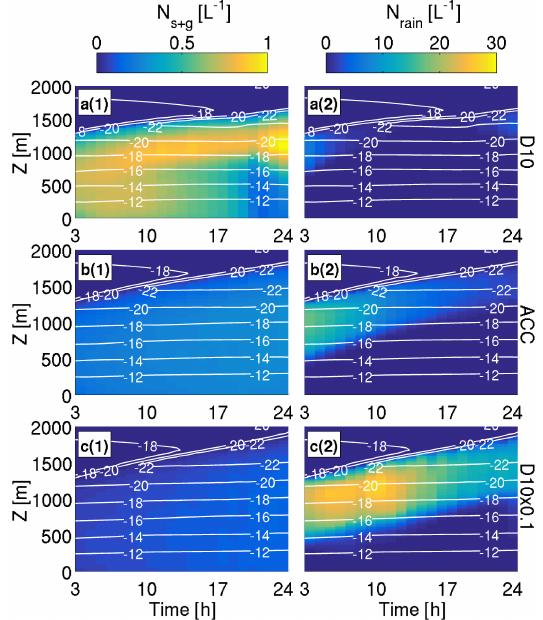
Figure 12. Summed snow and graupel number concentrations ( N s + g , a1–c1 ) and rain number concentration ( N rain , a2–c2 ) us- ing (a) D10 , (b) ACC, and (c) D10 × 0.1 during case 3. Run length 24h. Temperature ( ◦ C) contours are overlaid in white. Note chang- ing colour bar at the top of each column, which corresponds to data in that column